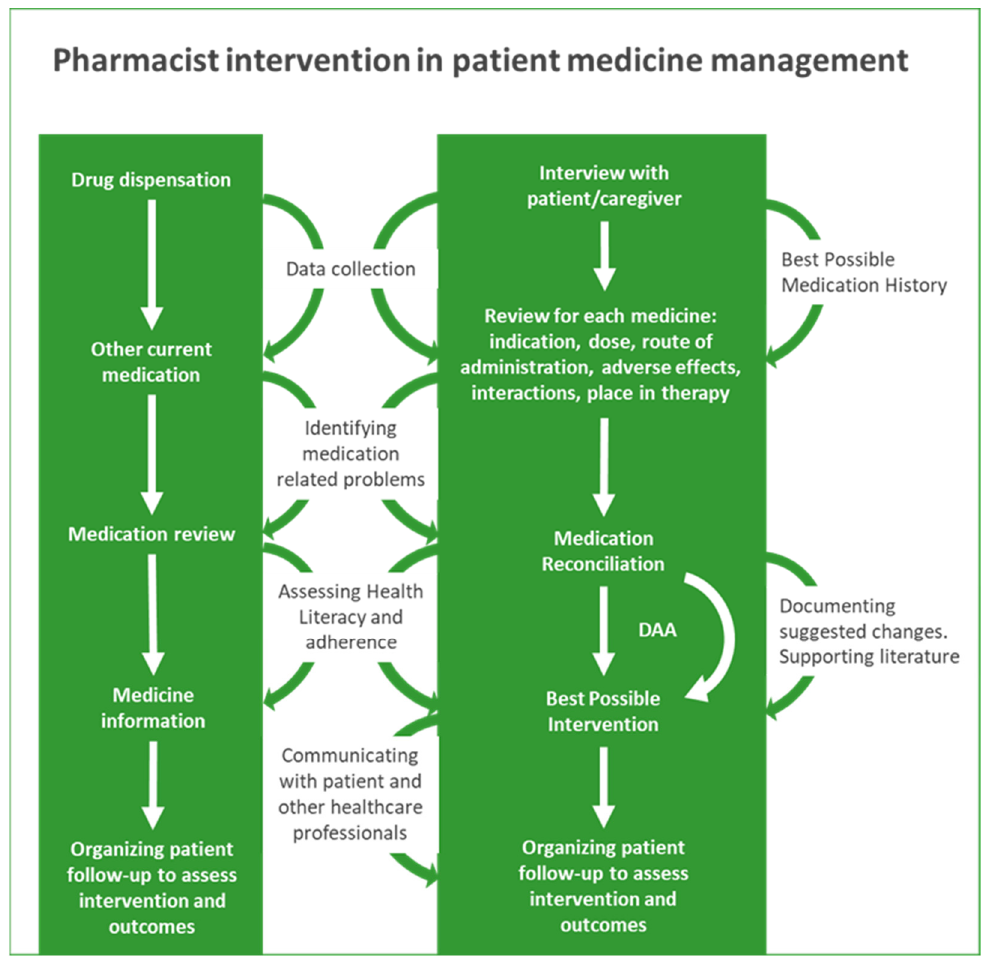
Figure 1. Pharmacist intervention in patient medication management.